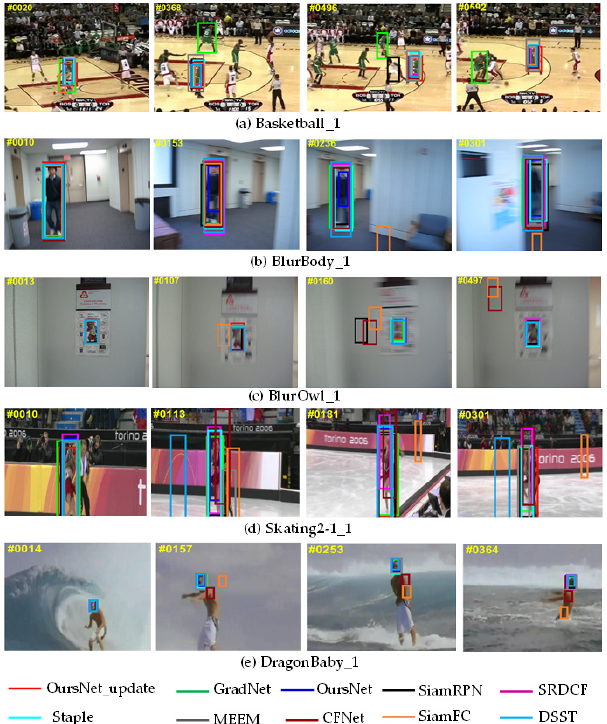
Figure 10. Sample tracking results of evaluated algorithms on different challenging sequences .